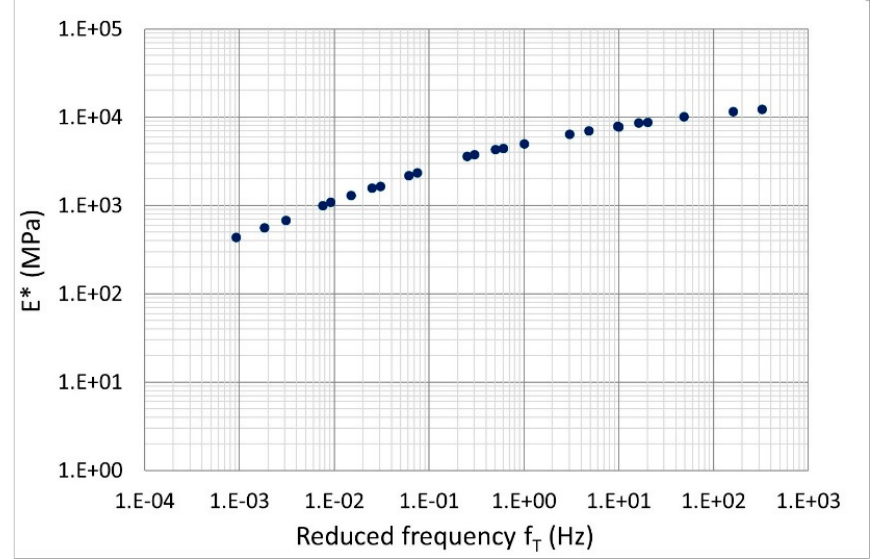
Figure 4. SMACR master curve at 20 °C.